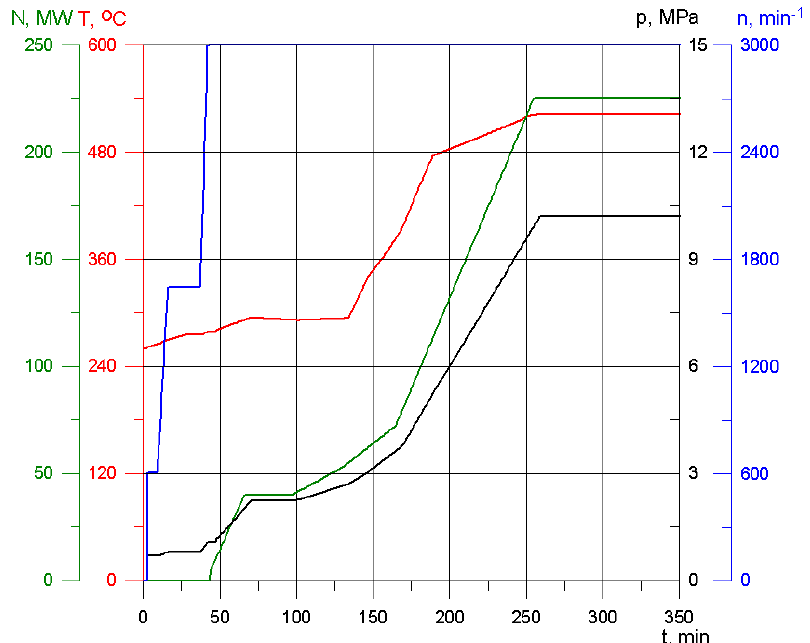
Figure 2. Change in parameters during original rotor cold start-up: N —turbine power, T —steam temperature, p —steam pressure, n —rotational